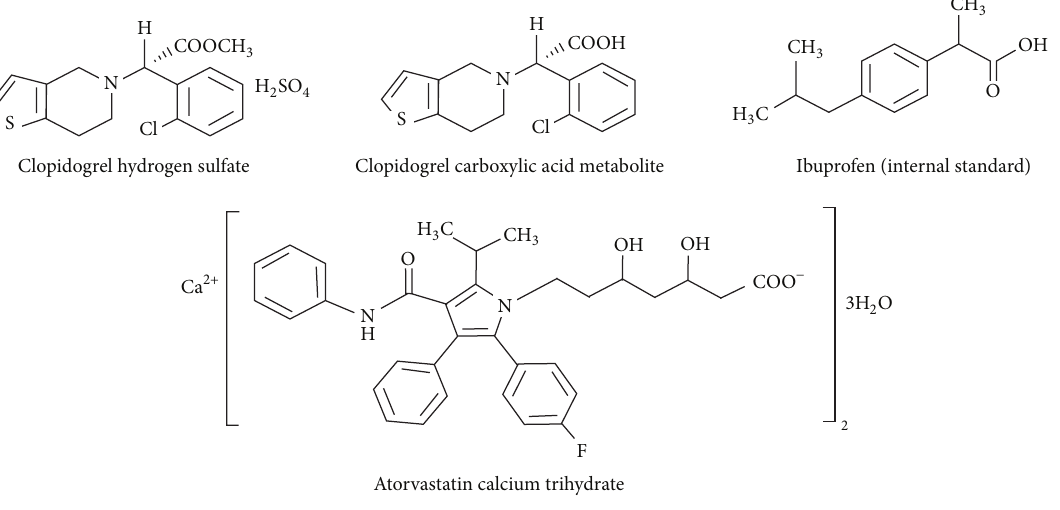
Figure 1: Chemical structure of clopidogrel hydrogen sulfate, its carboxylic acid metabolite, atorvastatin, and ibuprofen (internal standard).